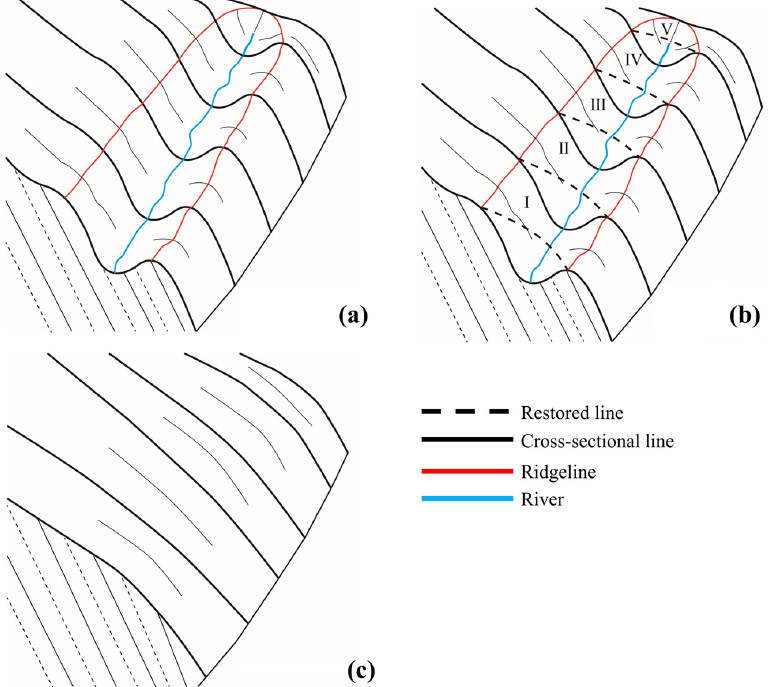
Figure 19. An illustration of the secondary valley on one of the anticline’s wings. ( a ) The secondary valley simulation model; ( b ) filling the missing portion of each cross-sectional line and splitting many subareas; and ( c ) the secondary valley’s paleotopography.